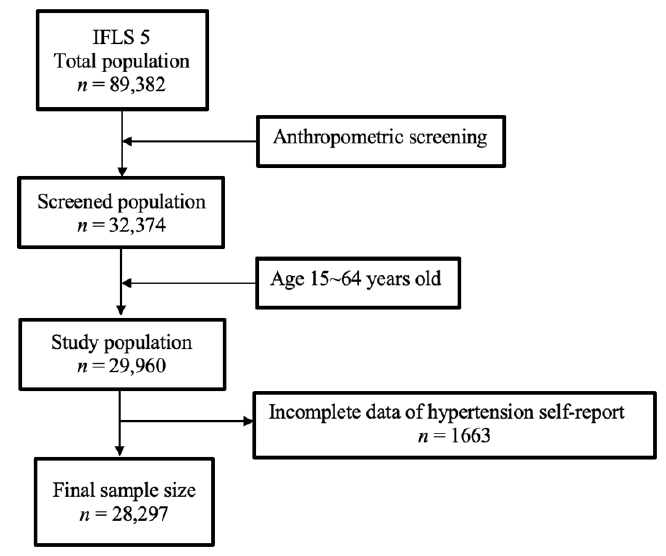
Figure 1. Sample screening